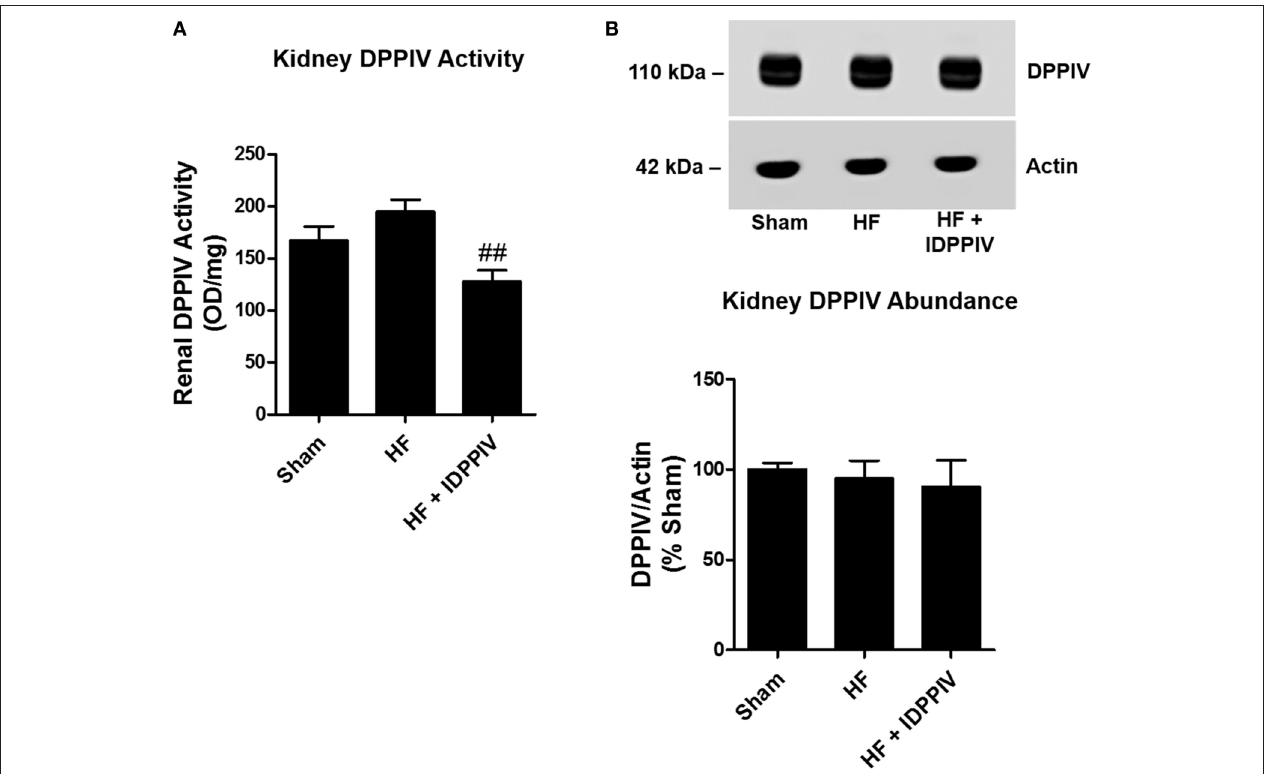
FIGURE 4 | Renal DPPIV activity and expression in sham and HF rats treated with the DPPIV inhibitor vildagliptin or with the vehicle. (A) Renal DPPIV activity was measured in sham and HF rats treated with vehicle (HF) or vildagliptin (HF + IDPPIV) by colorimetry. (B) Renal cortical DPPIV abundance was evaluated by immunoblotting. Equal amounts of protein (10 µ g for DPPIV and 5 µ g for actin) were subjected to SDS-PAGE, transferred to a PVDF membrane and incubated with the following primary antibodies: anti-DPPIV (1:1000) and anti-actin (1:50,000). Membranes were stained with Ponceau S prior to antibody incubation, and the Actin was used as an internal control. Values are means ± SEM. ## p < 0.01 vs. HF.